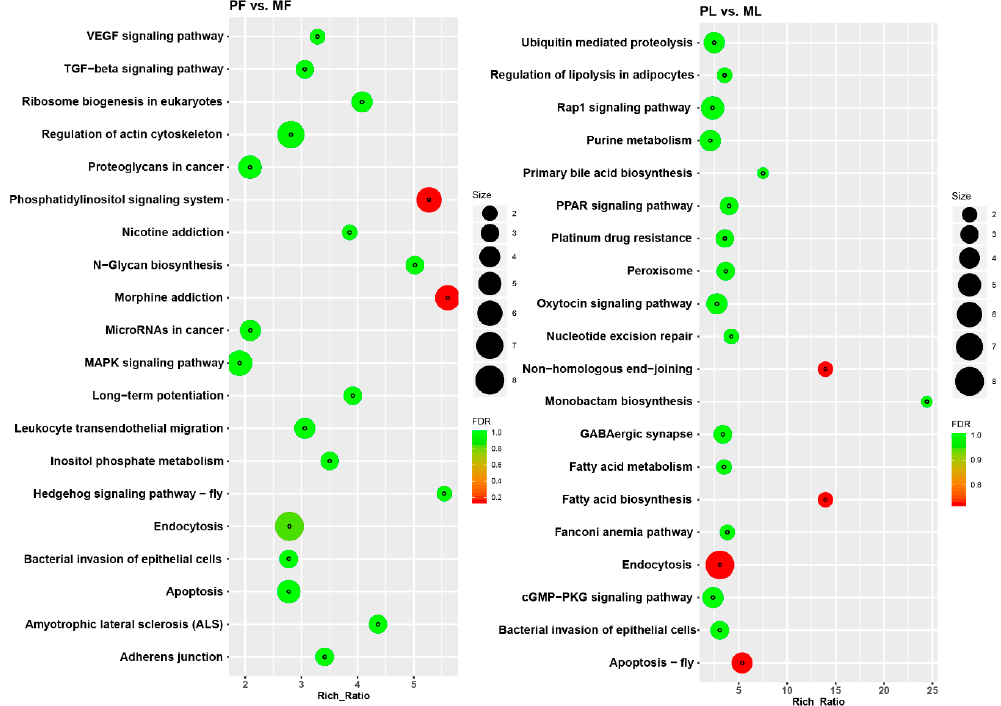
Figure 7. Kyoto Encyclopedia of Genes and Genomes pathway enrichment analysis. ( A ) The top 20 pathways enriched in polytocous sheep in the follicular phase versus monotocous sheep in the follicular phase (PF vs. MF). ( B ) The top 20 pathways enriched in polytocous sheep in the luteal phase versus monotocous sheep in the luteal phase (PL vs. ML). Notes: FDR: False discovery rate.